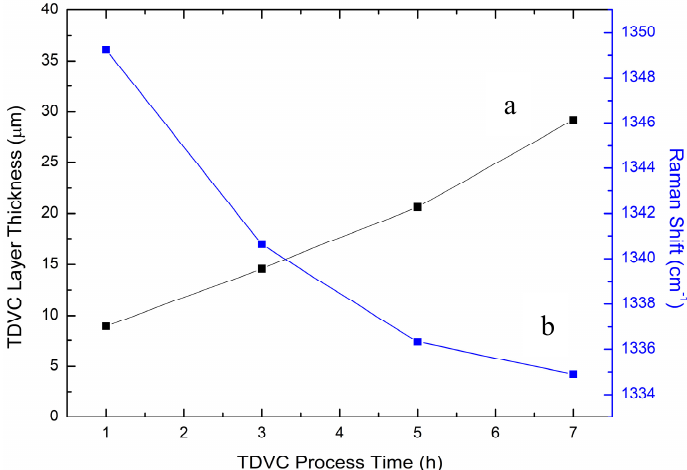
Figure 2. ( a ) Thickness of the vanadium carbide (VC) layer and ( b ) Raman shift (cm − 1 ) of diamond film grown on such a VC interlayer, as a function of Thermodiffused Vanadium Carbide Coating (TDVC) process time.